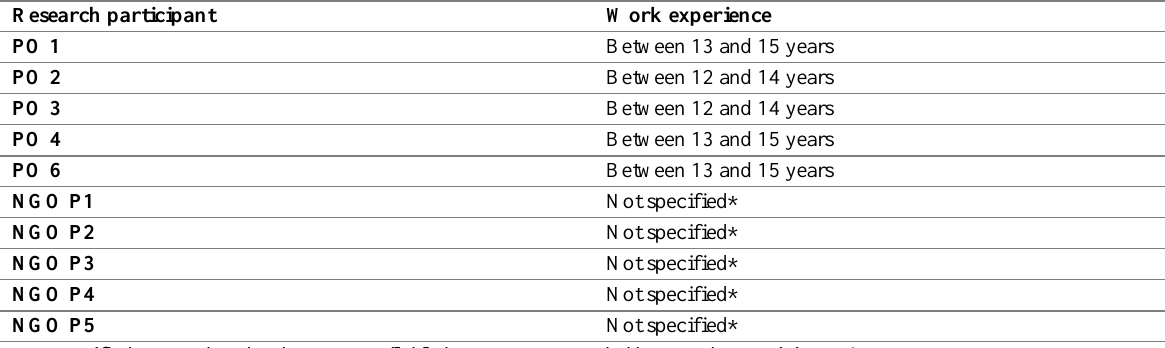
Table 1: Years of experience of the